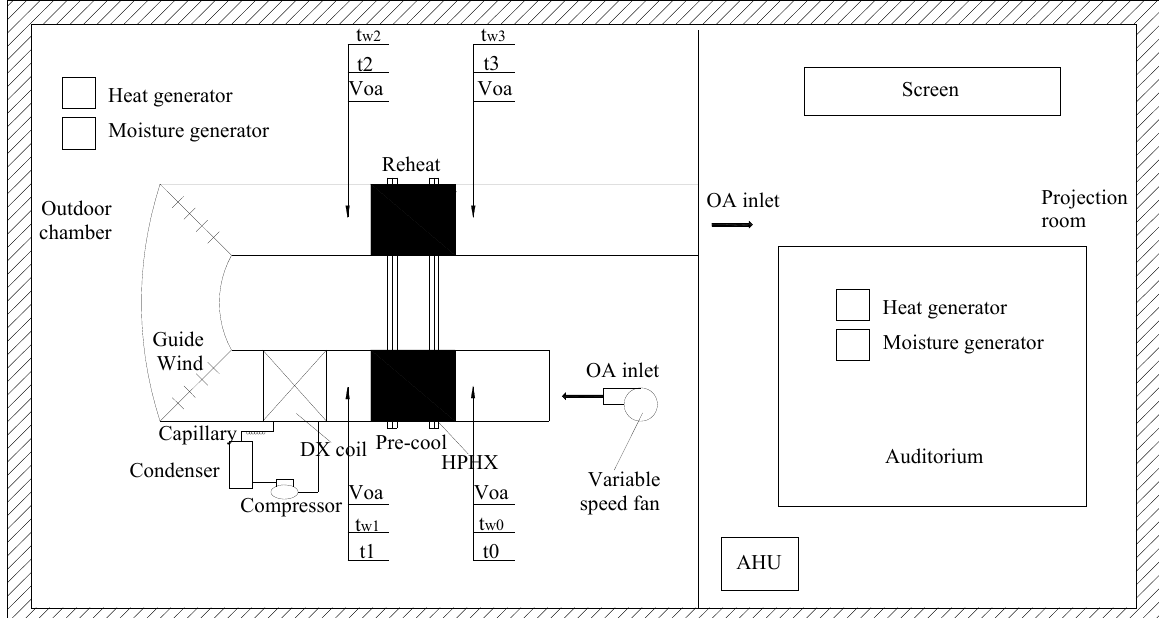
Figure 9. The experimental set-up. OA—Outdoor Air; AHU—Air Handling Unit; DX coil—Direct Expansion A/C coil; HPHX—Heat Pipe Heat